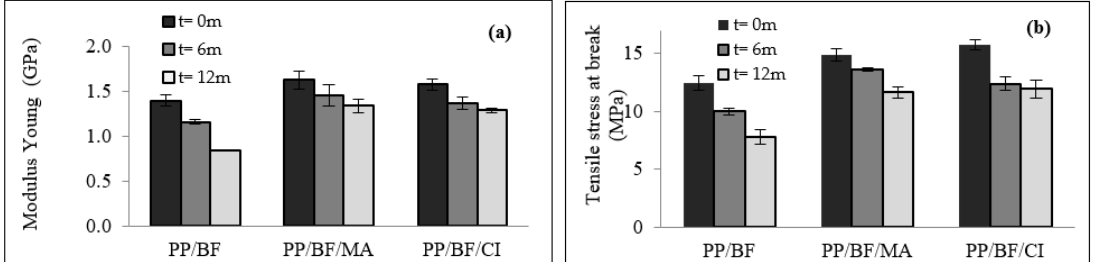
Figure 1. Tensile test results of composites exposed to weathering: ( a ) Modulus Young; ( b ) Tensile stress at break.